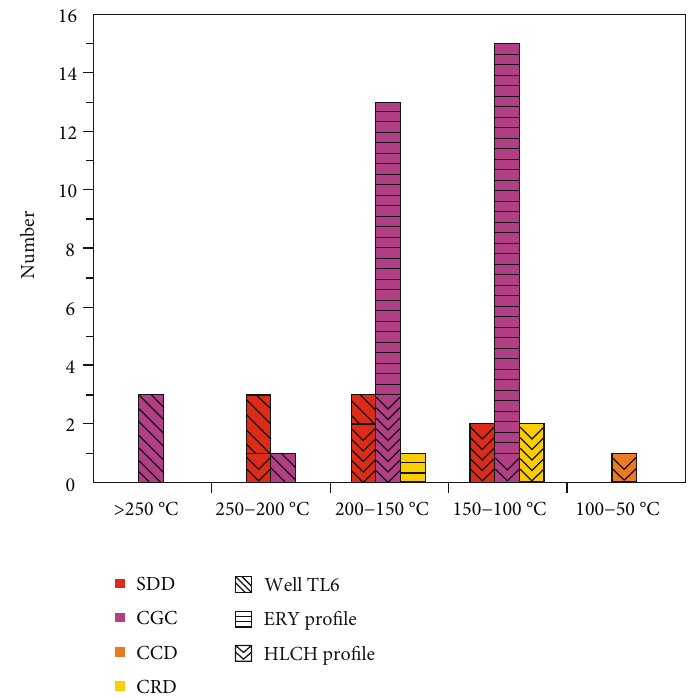
Figure 10: Frequency distribution histogram of homogenous temperatures of fl uid inclusions in di ff erent dolomite components of the Maokou Formation in Eastern